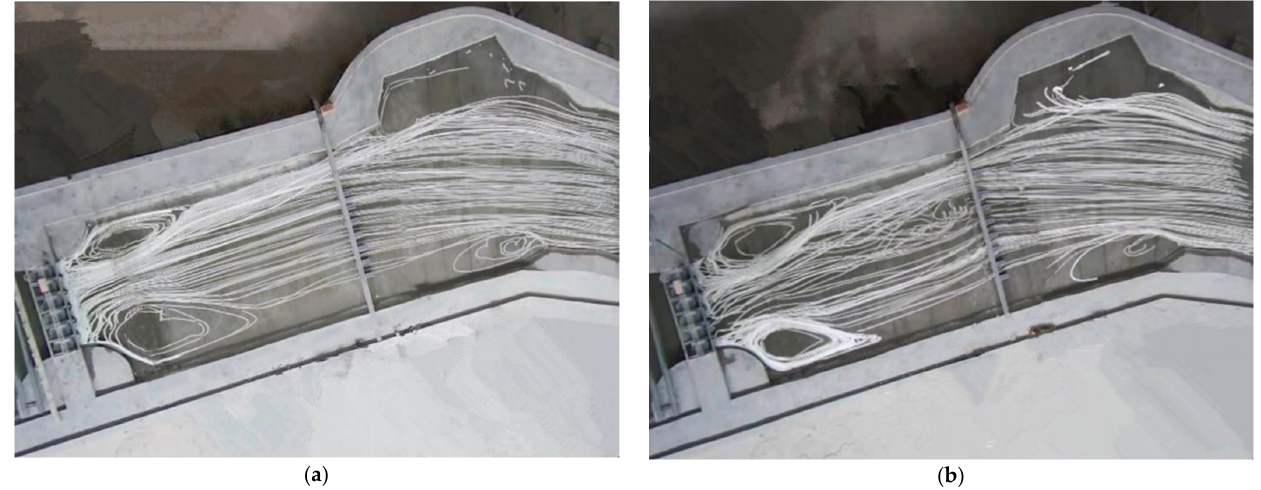
Figure 13. Modified flow patterns with the guide vanes (case 2). ( a ) α = 0°; ( b ) α = 30°.